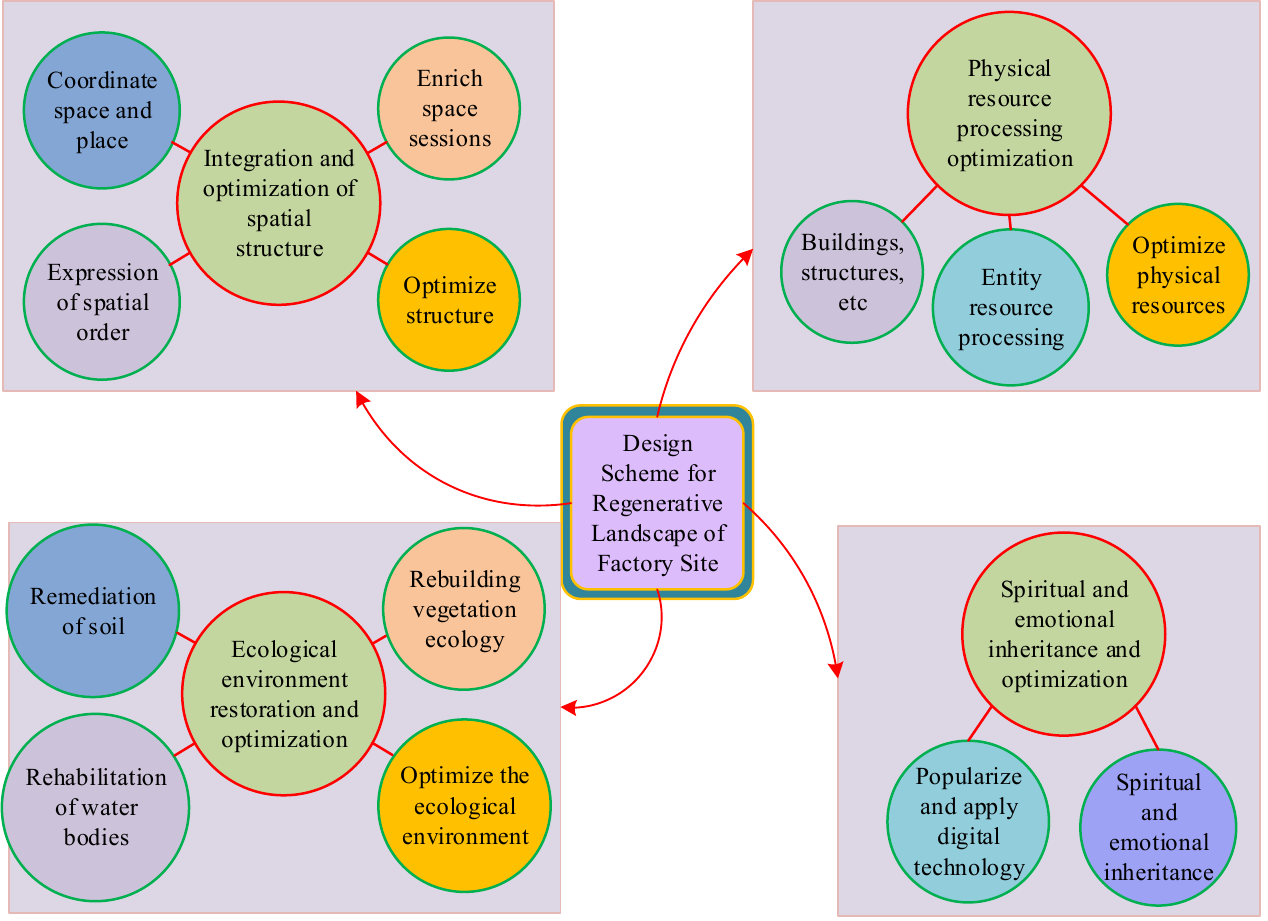
Figure 1. Design Scheme for Regenerative Landscape of Factory Site.